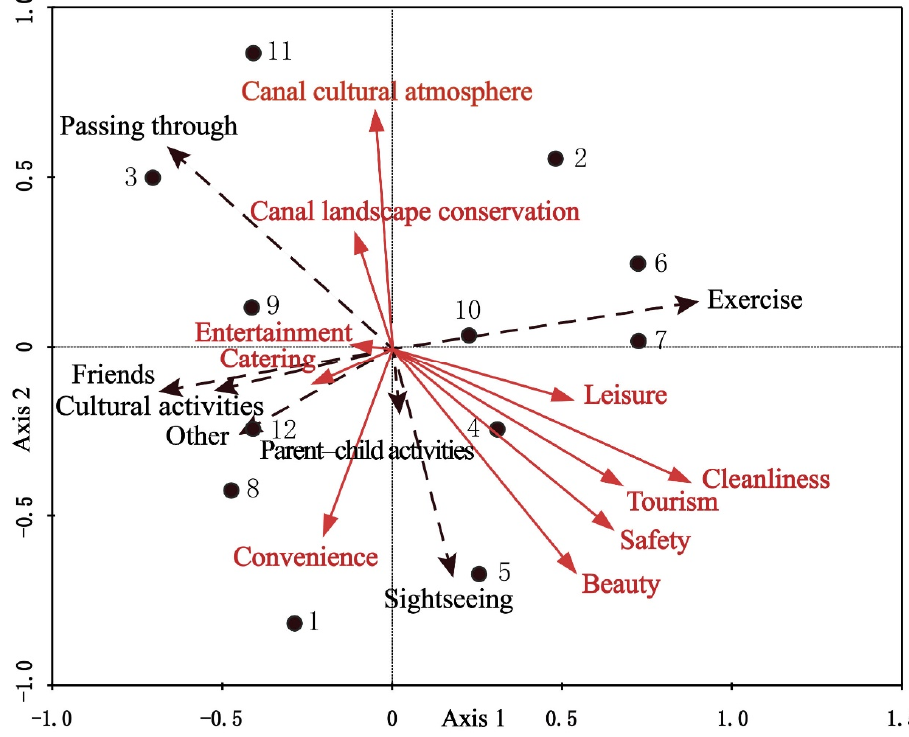
Figure 3. Redundancy analysis (RDA) ordination diagram of Jining respondents’ behaviors and environmental factors at 12 sample points.